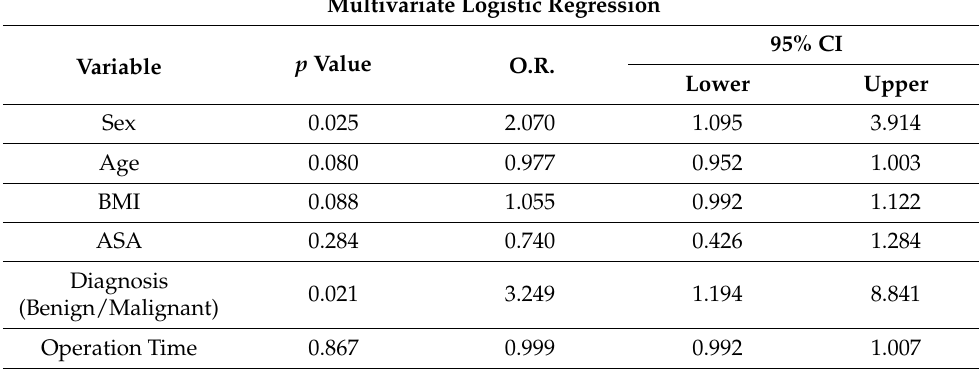
Table 4. Multivariate analysis for <24 h